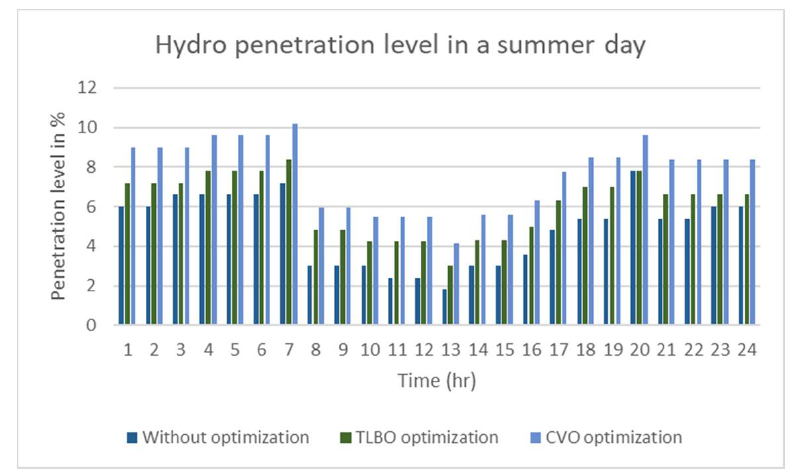
Figure 8. PV, wind and hydro penetration level in the Egyptian grid in a summer day.